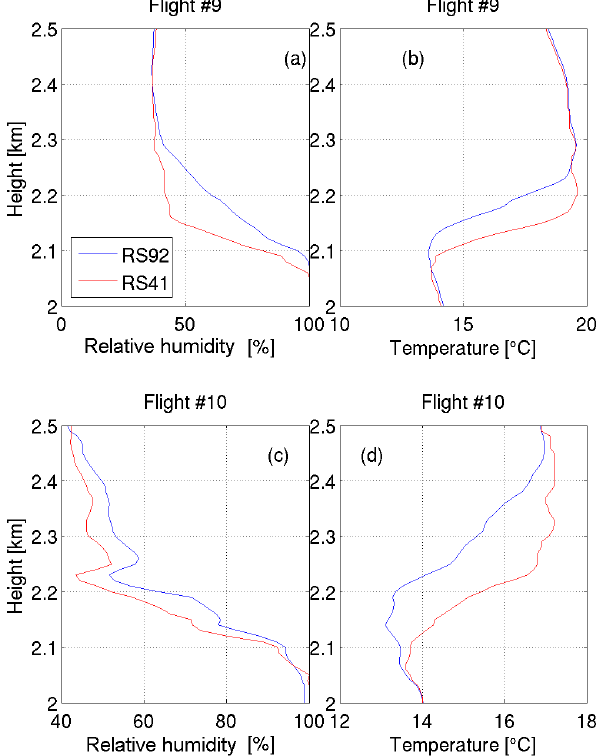
Figure 9. Comparison of relative humidity (a, c) and dry-bulb tem- perature (b, d) from flight no. 9 (top), launch time 5 June 2014 14:50UTC, and flight no. 10 (bottom), launch time 5 June 2014 16:34UTC.